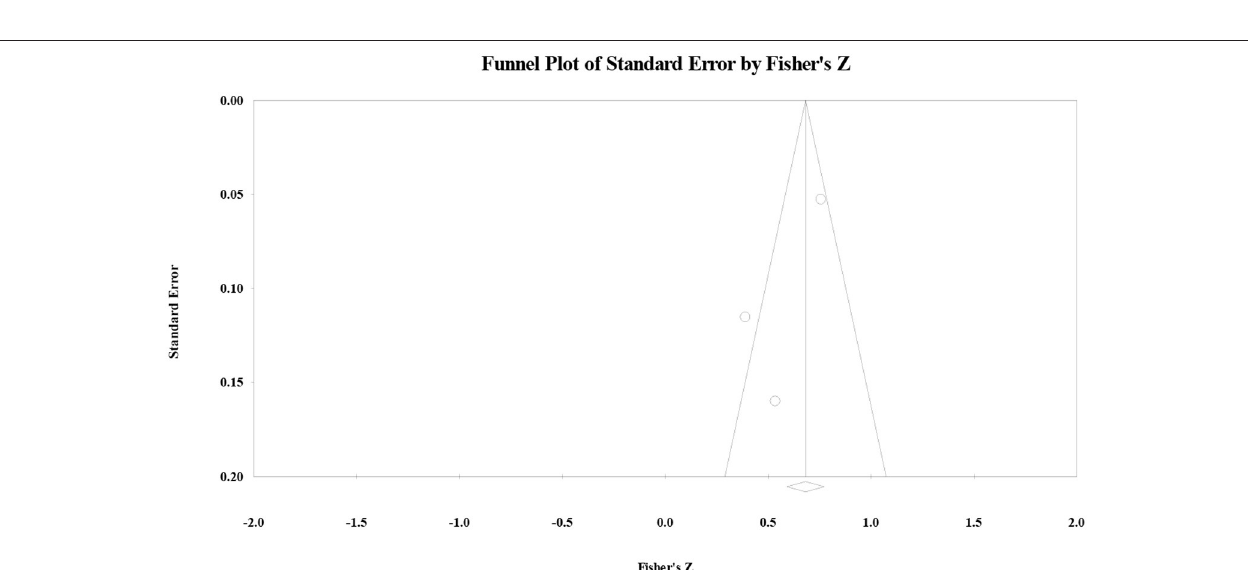
FIGURE 4 | Funnel plot of the correlation between the organization strategy and reading comprehension.